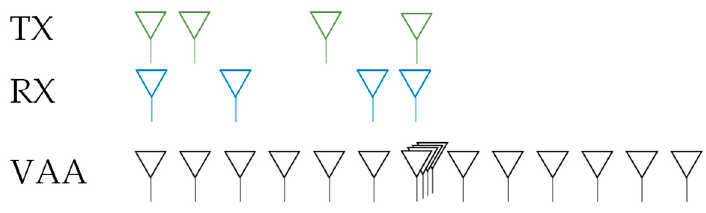
Figure 10. TX and RX antenna with an MRA structure and the resulting VAA.